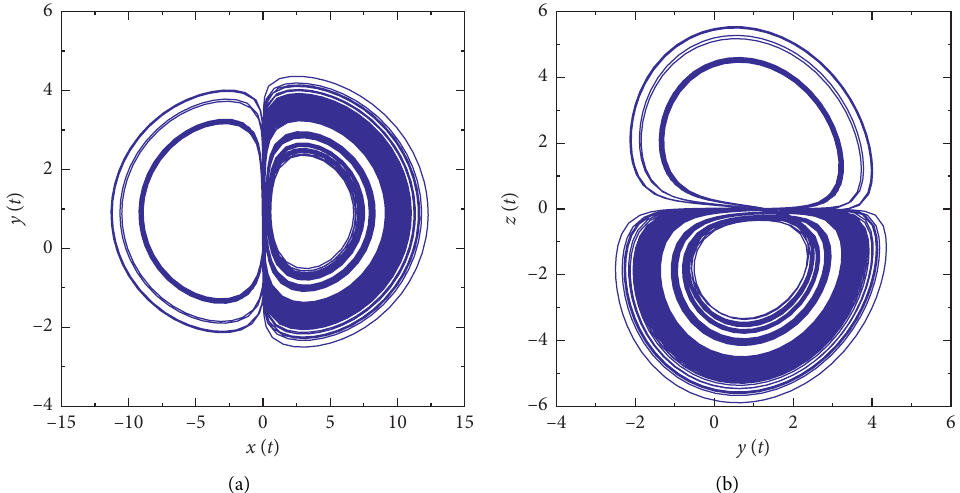
Figure 7: Phase diagrams of system (6) with fractional orders q the x − z phase plane.